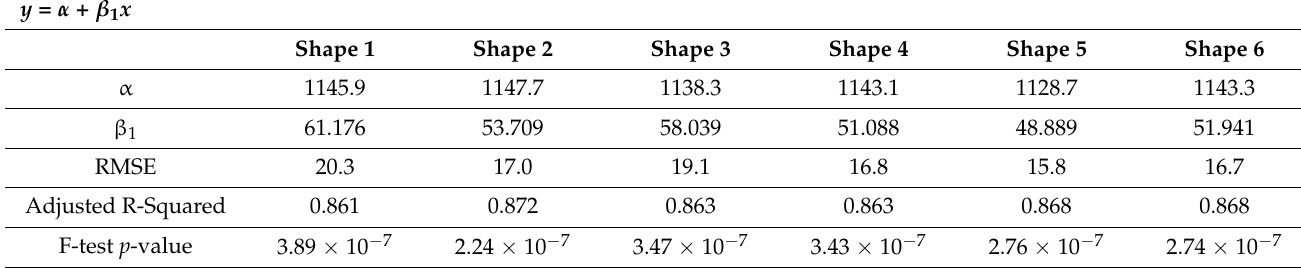
Table 10. Fitted lines of wall construction type